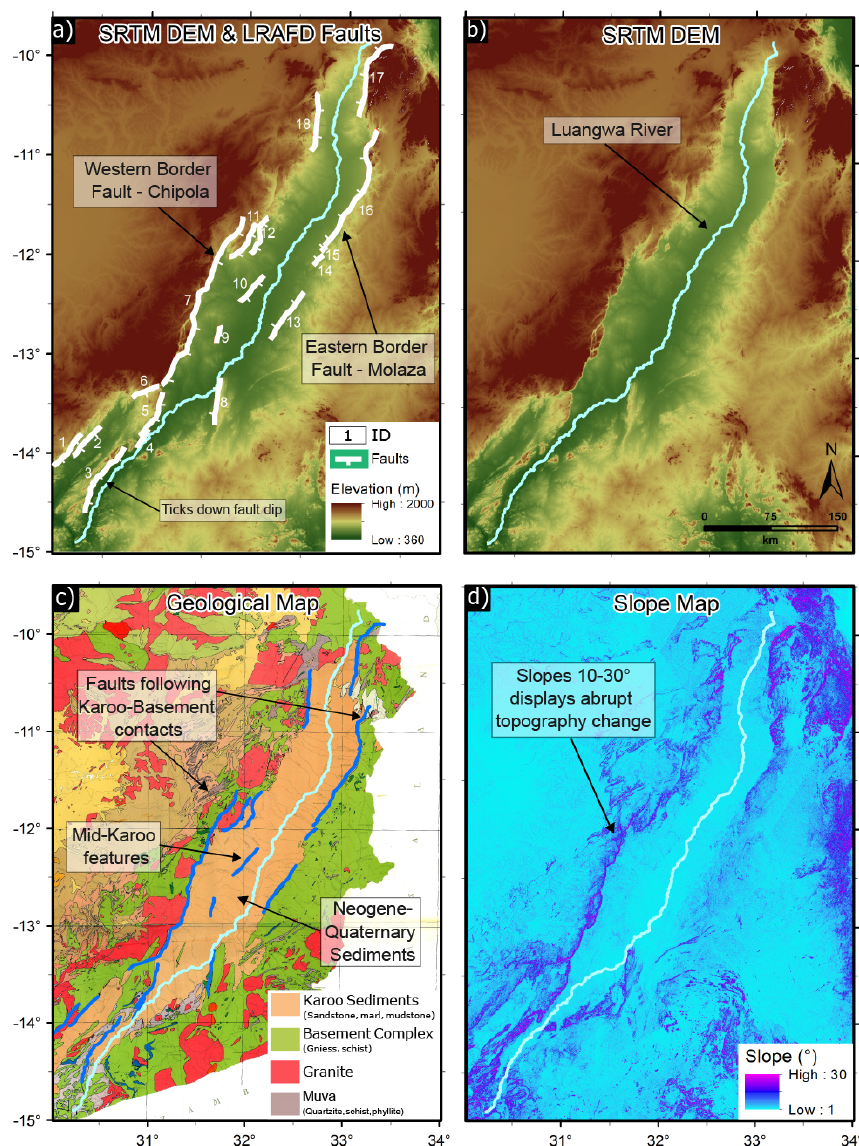
Figure 4. Topography and geology of the Luangwa Rift. Each figure represents a different technique used to map fault traces, denoted in the methods attribute of the LRAFD. (a) SRTM DEM of the rift with the 18 fault traces shown in red; the dip direction of each fault is indicated with the dash direction. (b) SRTM DEM without the fault traces. (c) Georeferenced geological map of the Luangwa Rift (adapted from Priday and Camps, 1960) overlain with fault traces in blue. Karoo sediments are overlain by Neogene–Quaternary sediments, not represented on the map (Utting, 1988; Banks et al., 1995; Bishop et al., 2016). Faults predominantly follow contacts between Karoo sediments and Basement complex, representing zones of weakness. (d) Slope map of the rift where increased slope values correspond to the steep fault scarps which were used to map